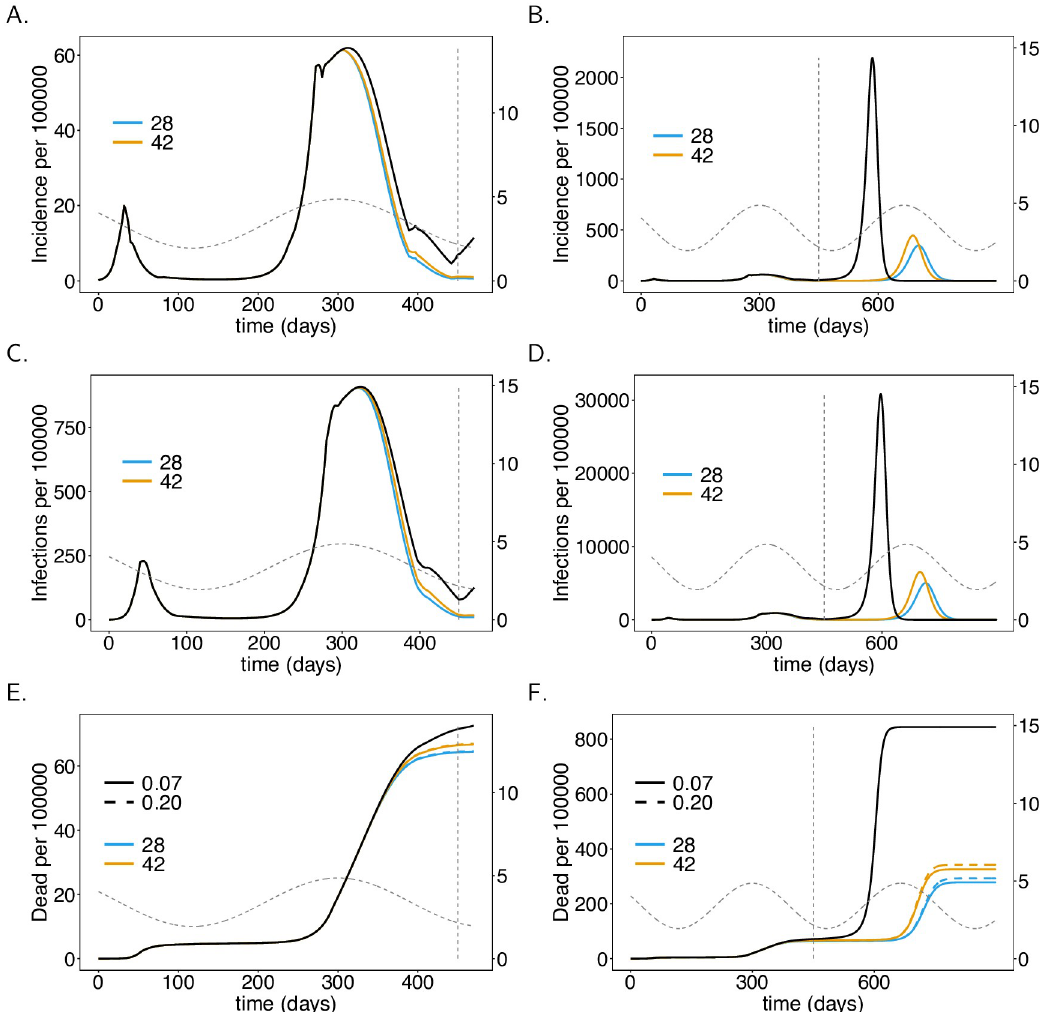
Fig 7. Vaccination schedule and time to immune response. As Fig 4, but for different average waiting times ( D A ) until the vaccinations manifests its outcome (immunizing effect), corresponding to vaccination schedules and times to immune